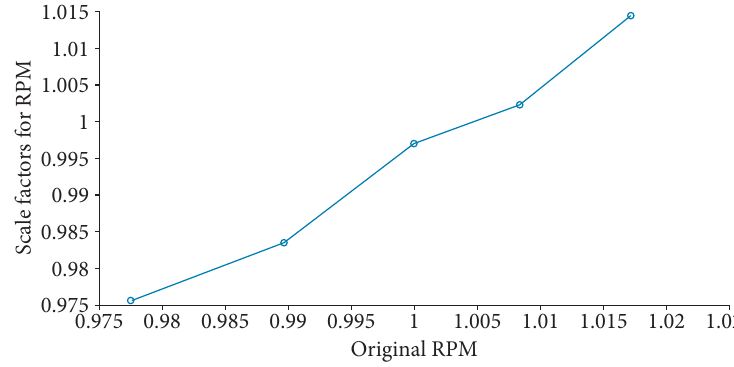
Figure 8. Scale factor to be applied to the HPC map RPM.